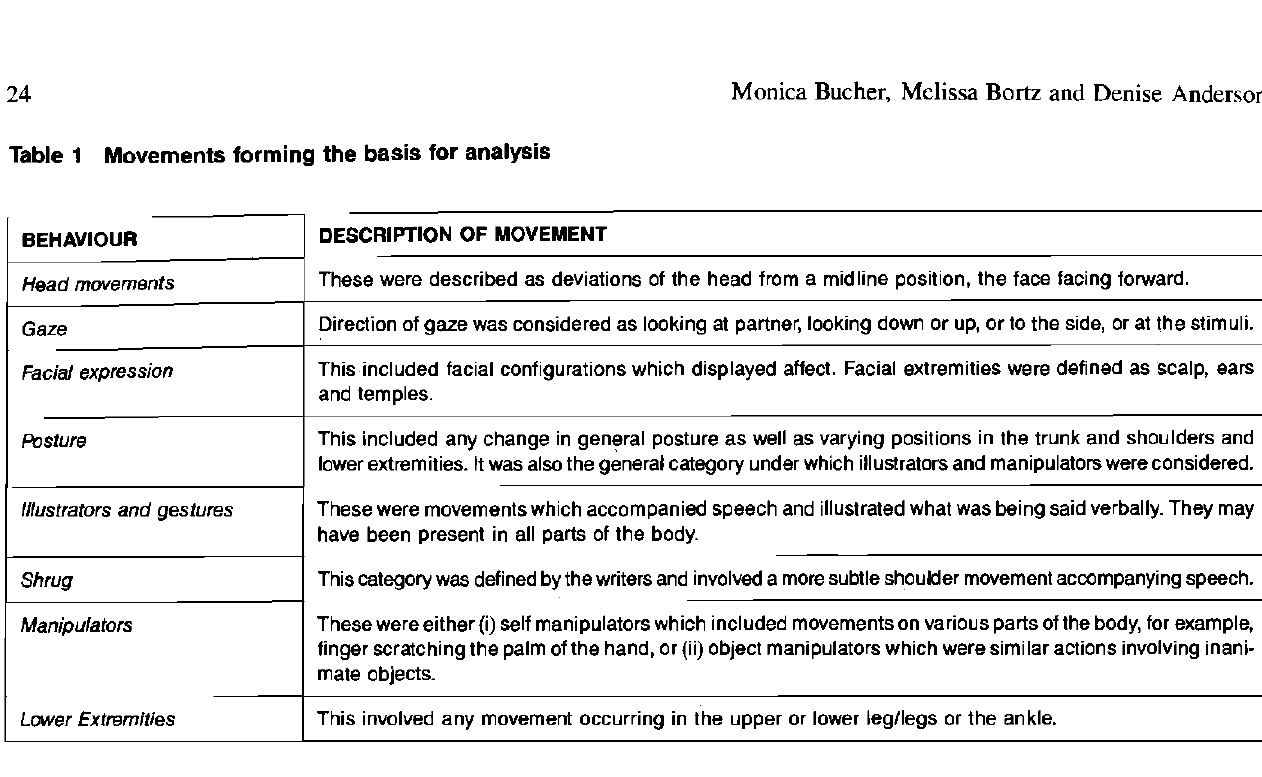
BEHAVIOUR DESCRIPTION OF MOVEMENT